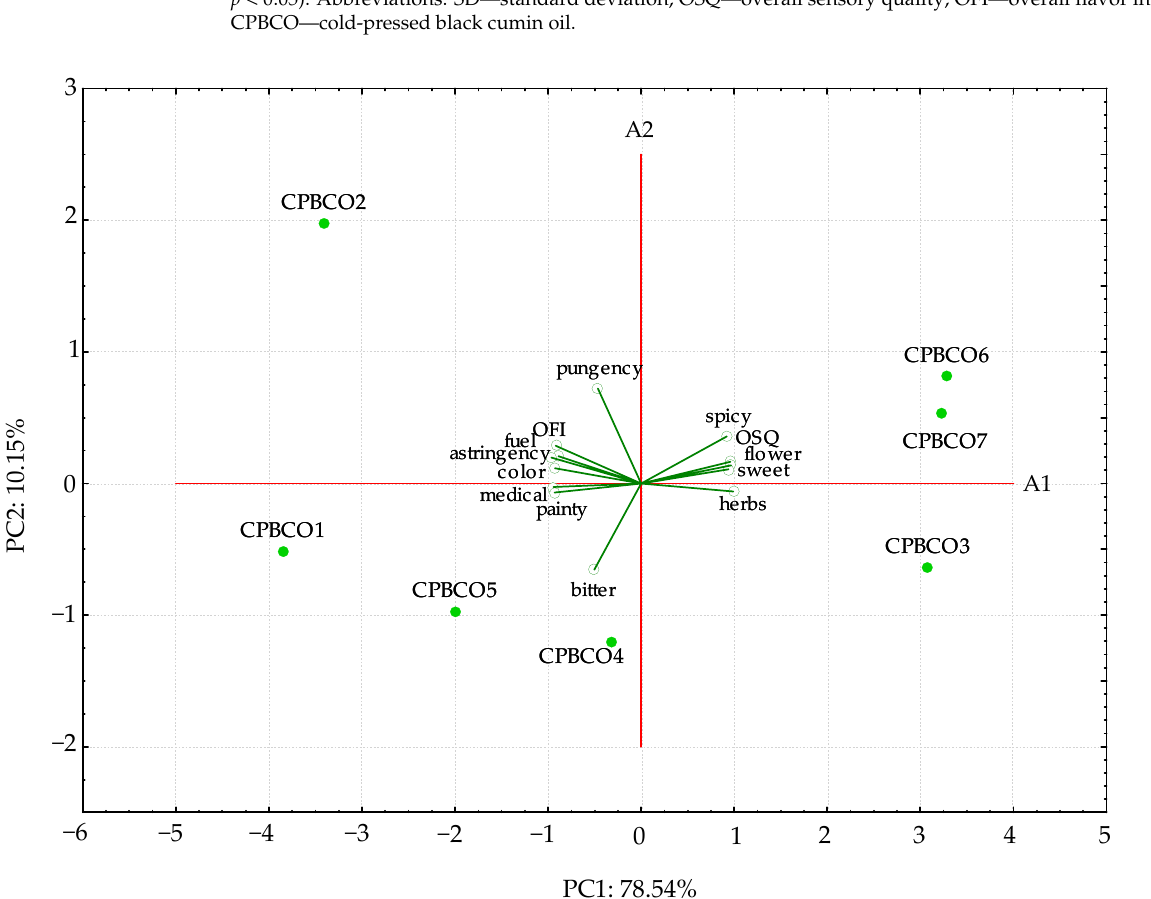
Figure 1. Biplot for PC1 and PC2 scores generated by the PCA of 12 attributes and OSQ for cold- pressed black cumin oils. Table 7. Means for the scoring of the overall sensory quality and sensory attributes.